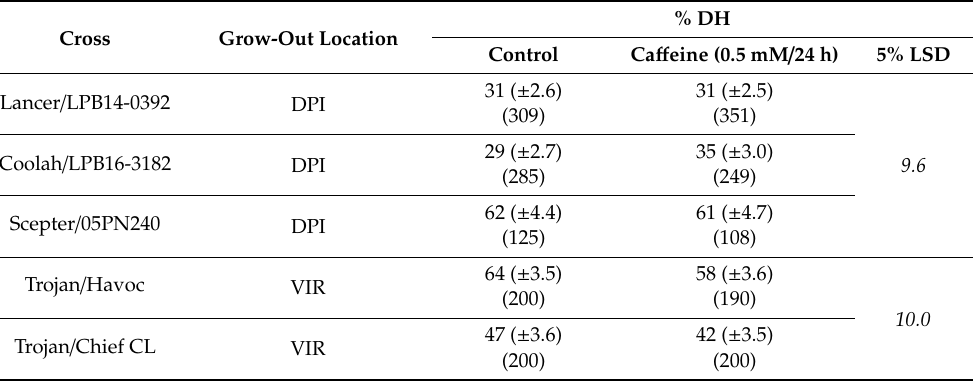
Table 3. Means ( ± SE) of chromosome doubling (% DH) following ca ff eine treatment during anther culture on five crosses in 2018. Plants were grown to maturity at DPIRD South Perth (DPI) or Virginia, South Australia (VIR). The number of plants transplanted for each treatment and cross is indicated in parentheses.